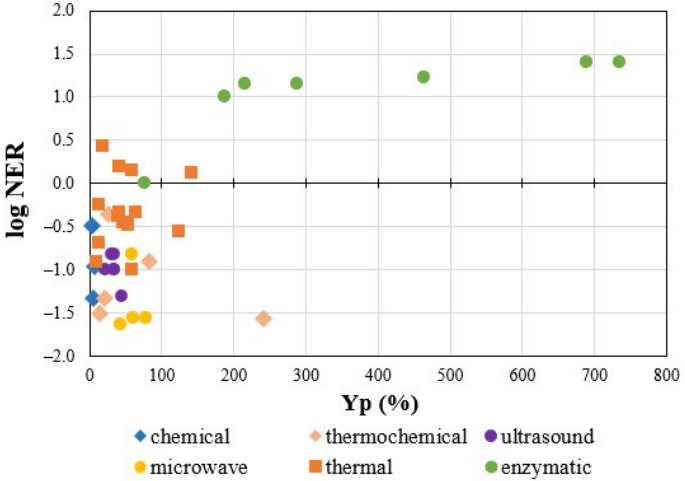
Figure 4. Net energy ratio of different algal biomass pretreatment methods and methane yield increment (Y p ).